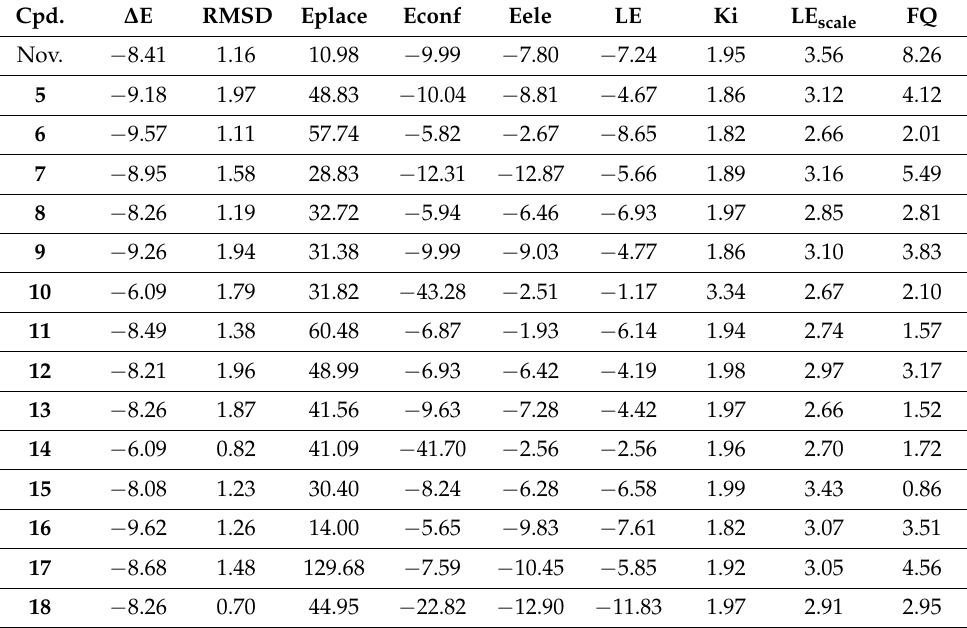
Table 7. Docking energy in (kcal/mol) and bioactivity analysis parameters against 4URO. Cpd.